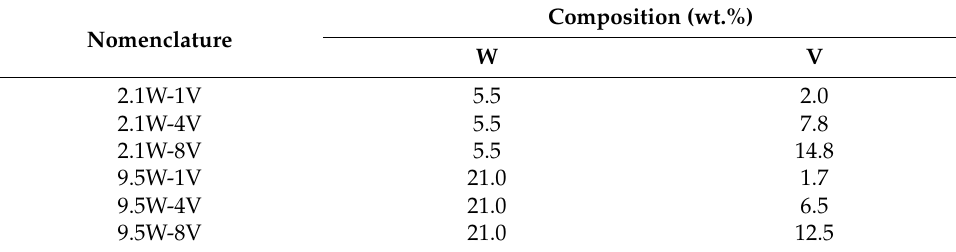
Table 1. Nomenclature and composition from X-ray fluorescence analysis of V 2 O 5 -WO 3 /TiO 2